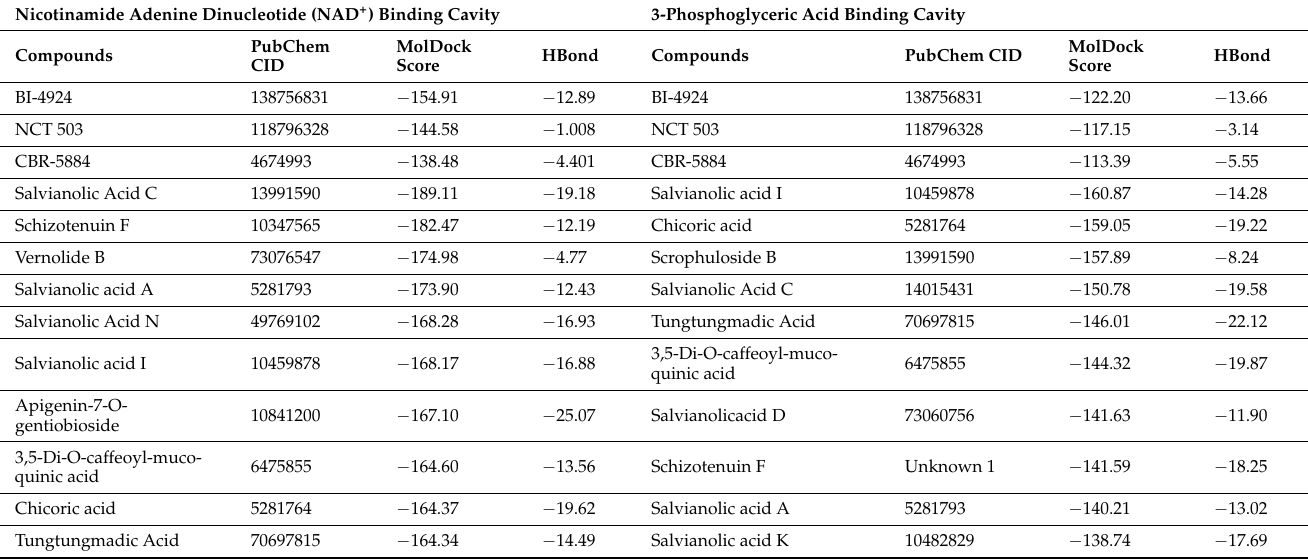
Table 1. Molecular docking score of hit phenolic compounds at the Nicotinamide adenine dinu-